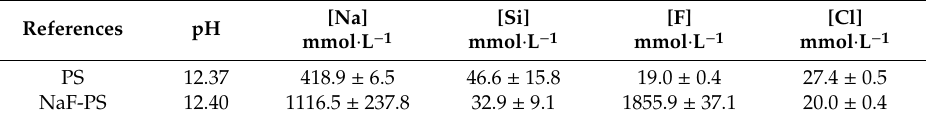
Table 2. References, pH and composition of the solutions used in this study.